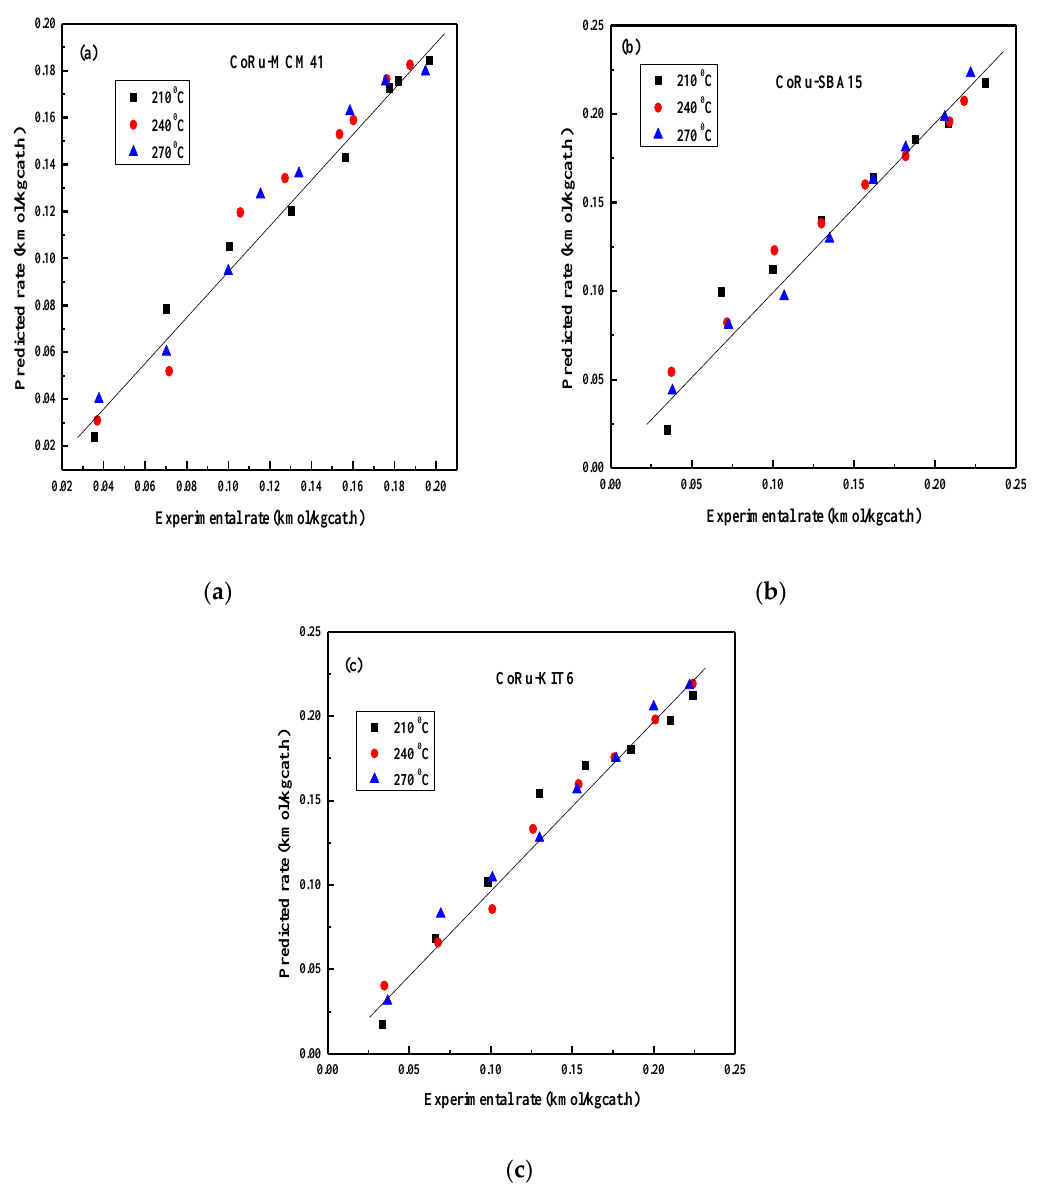
Figure 11. Experimental rate vs predicted rate for all temperature of three different catalysts: ( a ) CoRu-MCM-41; ( b ) CoRu-SBA-15; ( c ) CoRu-KIT-6.